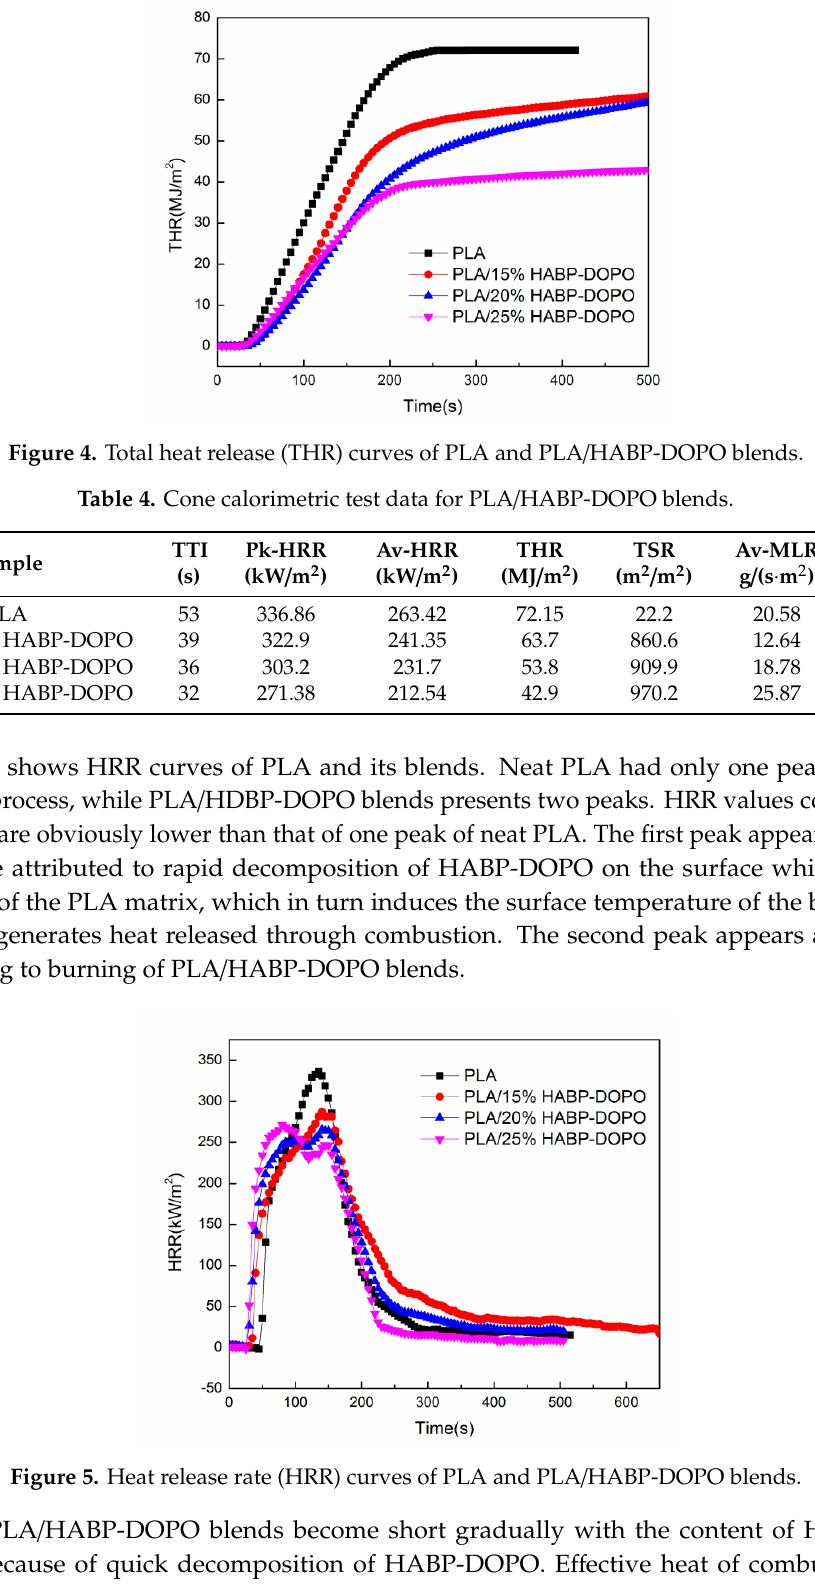
Figure 5. Heat release rate (HRR) curves of PLA and PLA/HABP-DOPO blends.